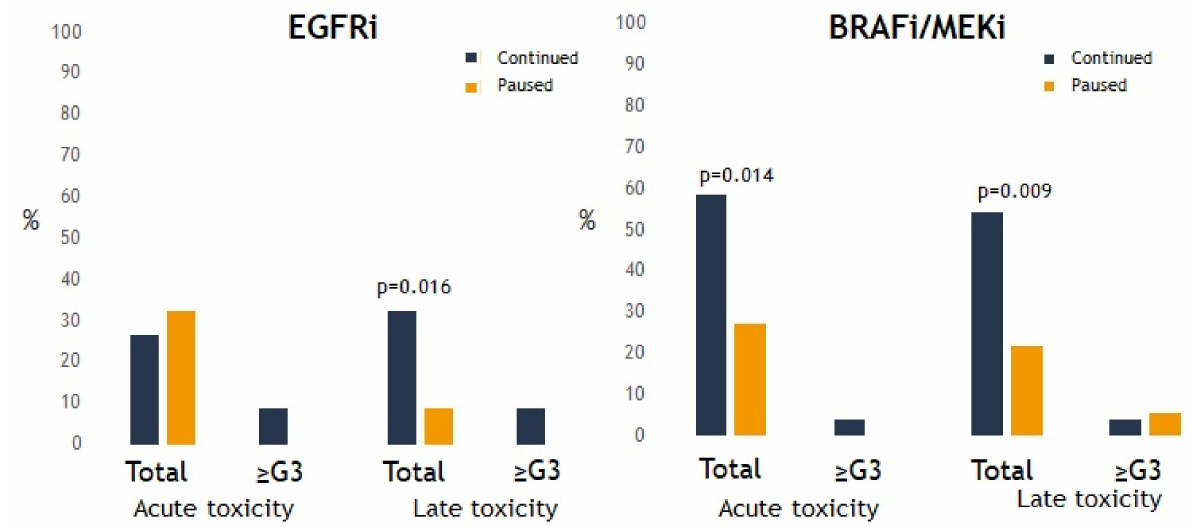
Figure 4. Presence of any-grade or severe toxicity after stereotactic radiotherapy (SRT) for every targeted therapy (TT) group. p < 0.05 is statistically